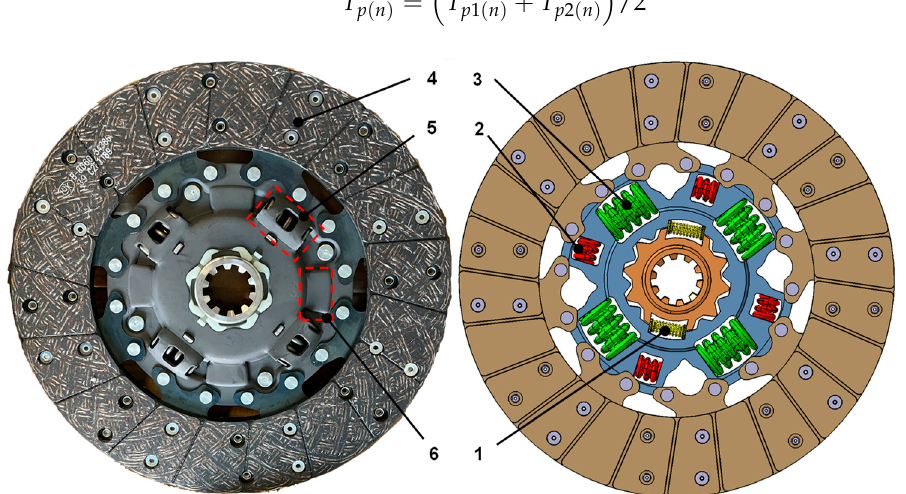
Figure 3. Structure of the three-stage clutch. (1. First stage spring; 2. Third stage spring; 3. Second stage spring; 4. Friction plate; 5. Spring window of second stage spring; 6. Spring window of third stage spring.)